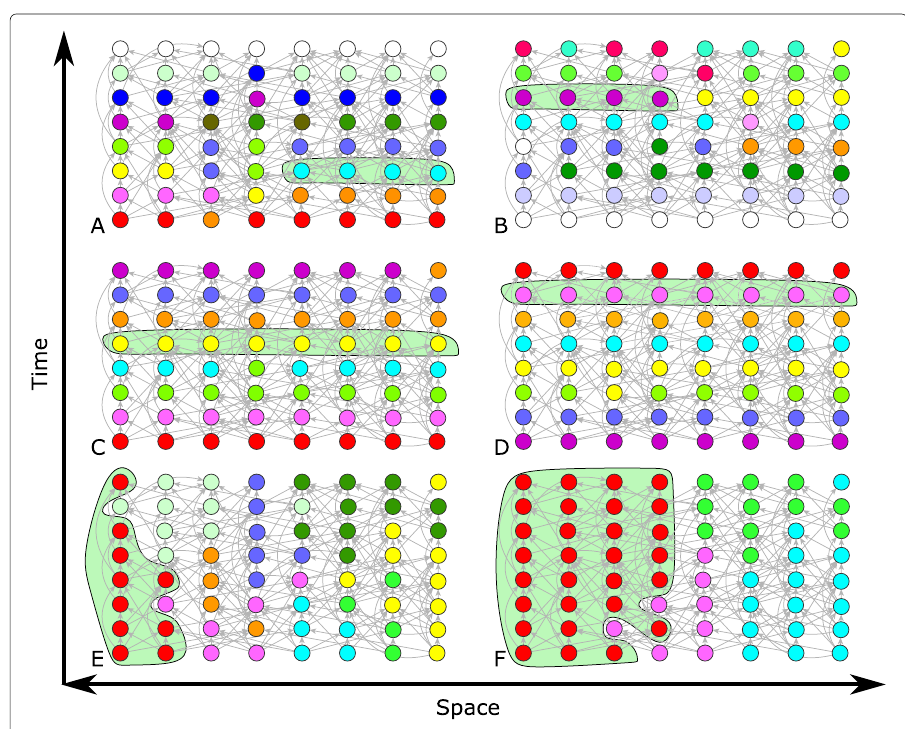
Fig. 3 Examples of various partitions of DAG from a simple space-time model. In this DAG, edges are more probable between two nodes if they are a shorter Manhattan distance apart (in the space-time). The time coordinate, which induces the acyclicity in the network, is vertical. Colour indicates community of a node. The top row shows siblinarity communities based on common successors ( a ), and predecessors ( b ). The central row shows layers based on height ( c ) and depth ( d ). The communities in the bottom row are from modularity community detection using resolution parameter value of one ( e ) and two ( f ). Nodes coloured white are in a community of size one. Siblinarity partitioning tends not to form communities (top row) which stretch across the whole network unlike those communities based on height or depth shown in the centre row. The communities found using traditional methods respect the spatial (horizontal) constraint but show no respect for the order in the DAG as they are spread over several times